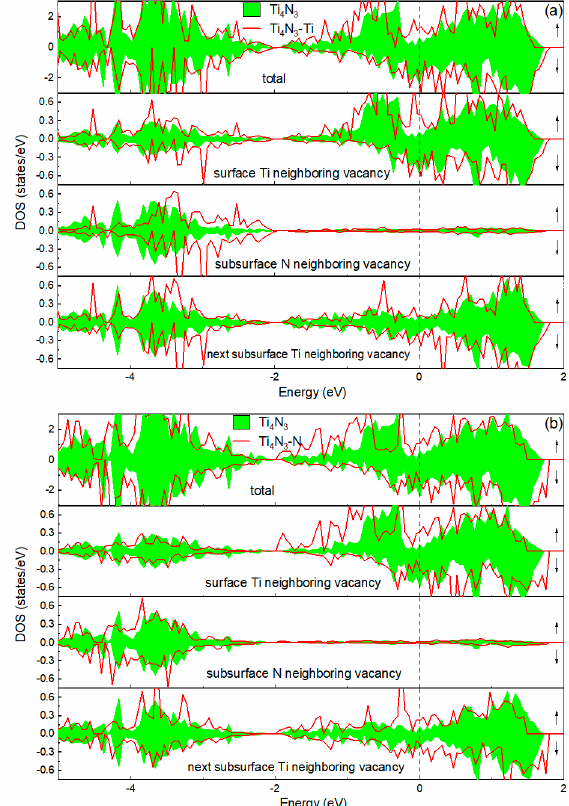
Figure 4. TDOS and PDOS of vacancy defected Ti 4 N 3 nanosheet: ( a ) Ti 4 N 3 -Ti and ( b )Ti 4 N 3 -N. ↑ and ↓ indicate the spin-up and spin-down orbitals, respectively. The Fermi level (dashed vertical line) is set to zero. The TDOS is transited to a primitive cell.